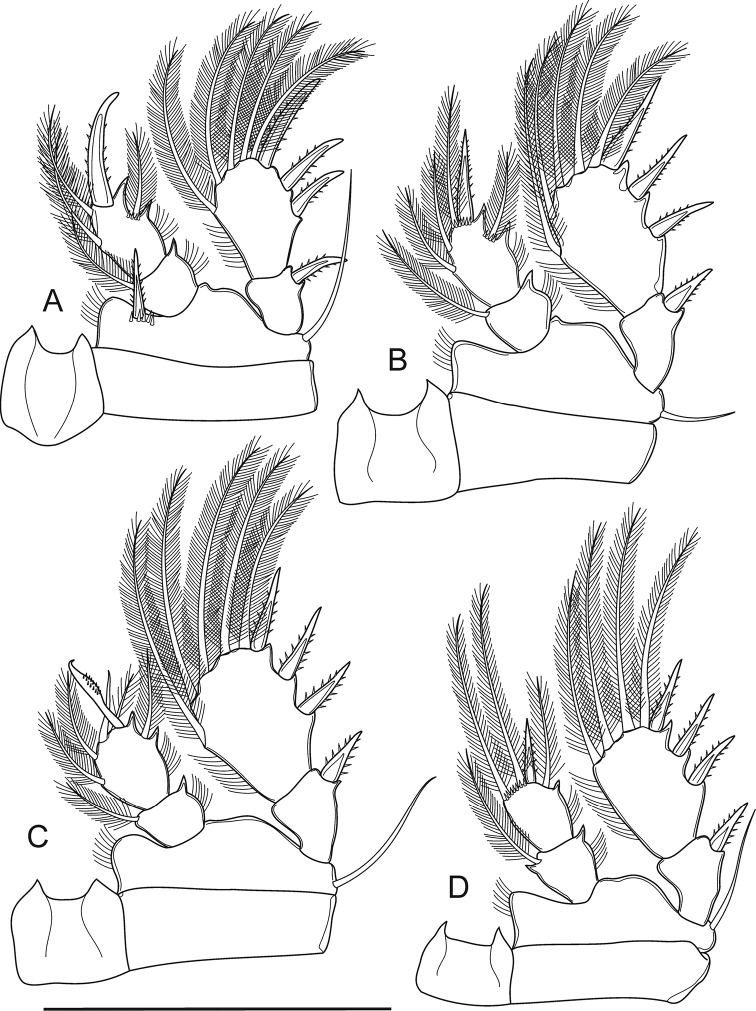
Bryocyclopsasetus sp. n., male AP1BP2CP3DP4. Scale bar: 50 μm.